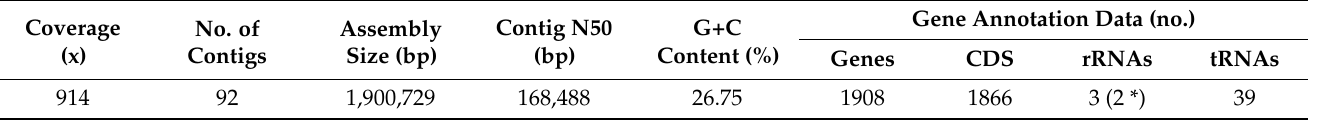
Table 1. MG1 genome assembly